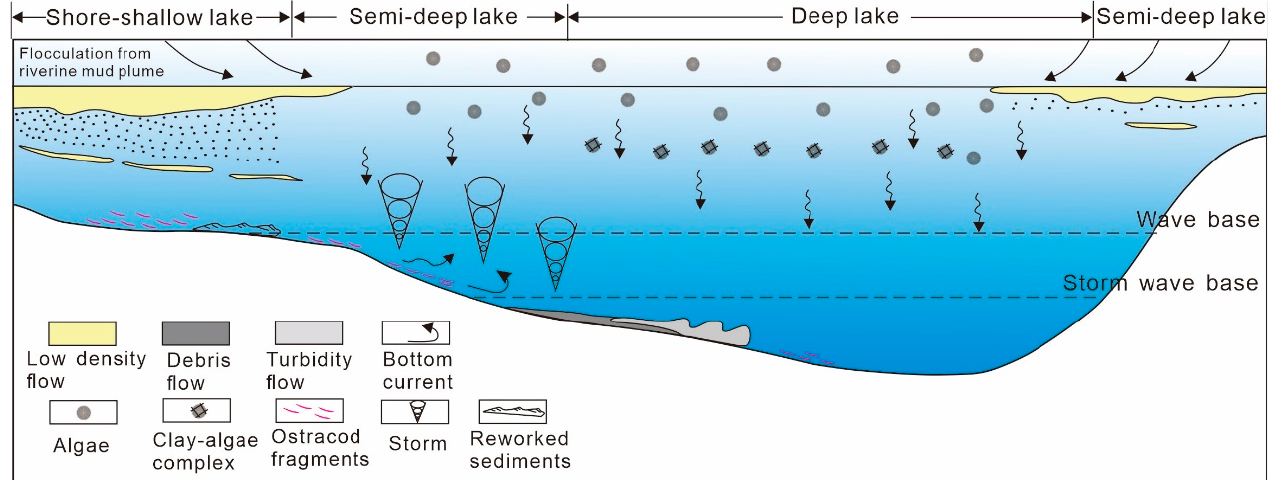
Figure 19. Depositional environment of FGSRs in the Qingshankou Formation.